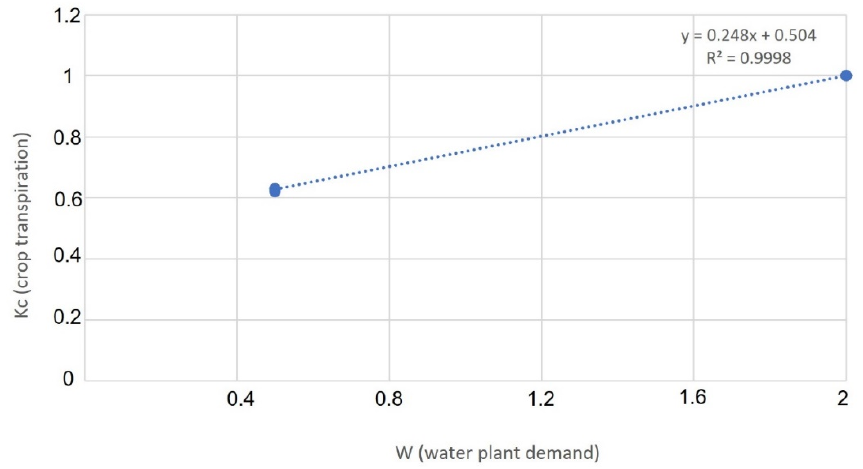
Figure 2. Regression line from Kc parameters (FAO) and W parameters for the land use classes not indicated in Zhang et al. [65]. Table 2. Parameters used for evaluation of soil loss by erosion and the real evapotranspiration.